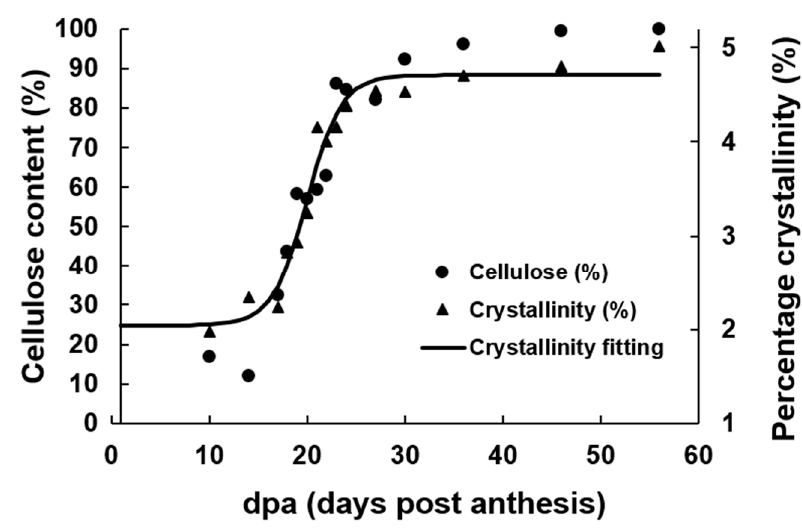
Figure 3. Percentage weight loss of cotton fibers from TM-1 genotype harvested at 20 and 56 dpa as a function of temperature.